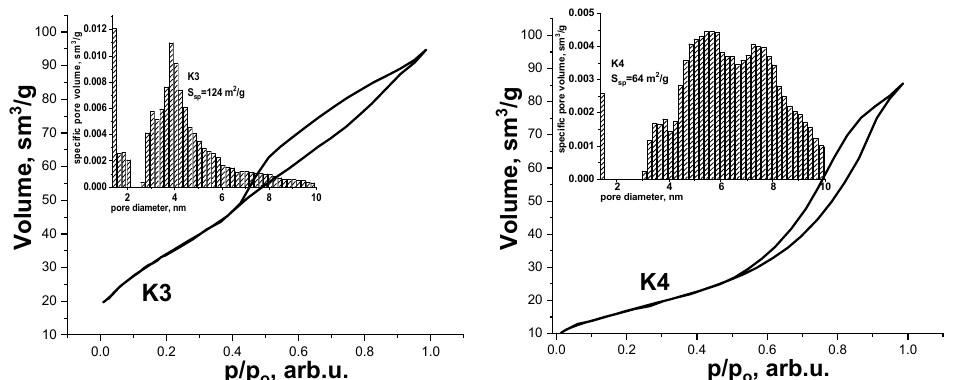
Figure 4. Adsorption-desorption isotherms for samples K3 and K4, the inserts show the corresponding size distribution of pores for synthesized materials.